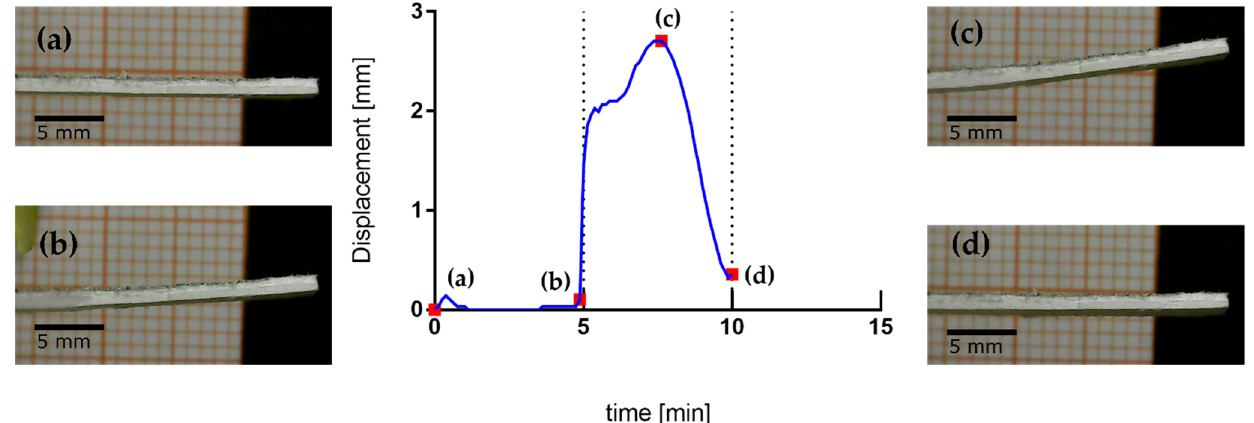
Figure 3. Activation/deactivation of paper cantilever-beam: ( a ) Initial position when connected to current control; ( b ) After 5 min, activation by volume solution; ( c ) Maximum displacement induced by hygroexpansion; ( d ) Deactivation/evaporation induced by current; return to initial position.